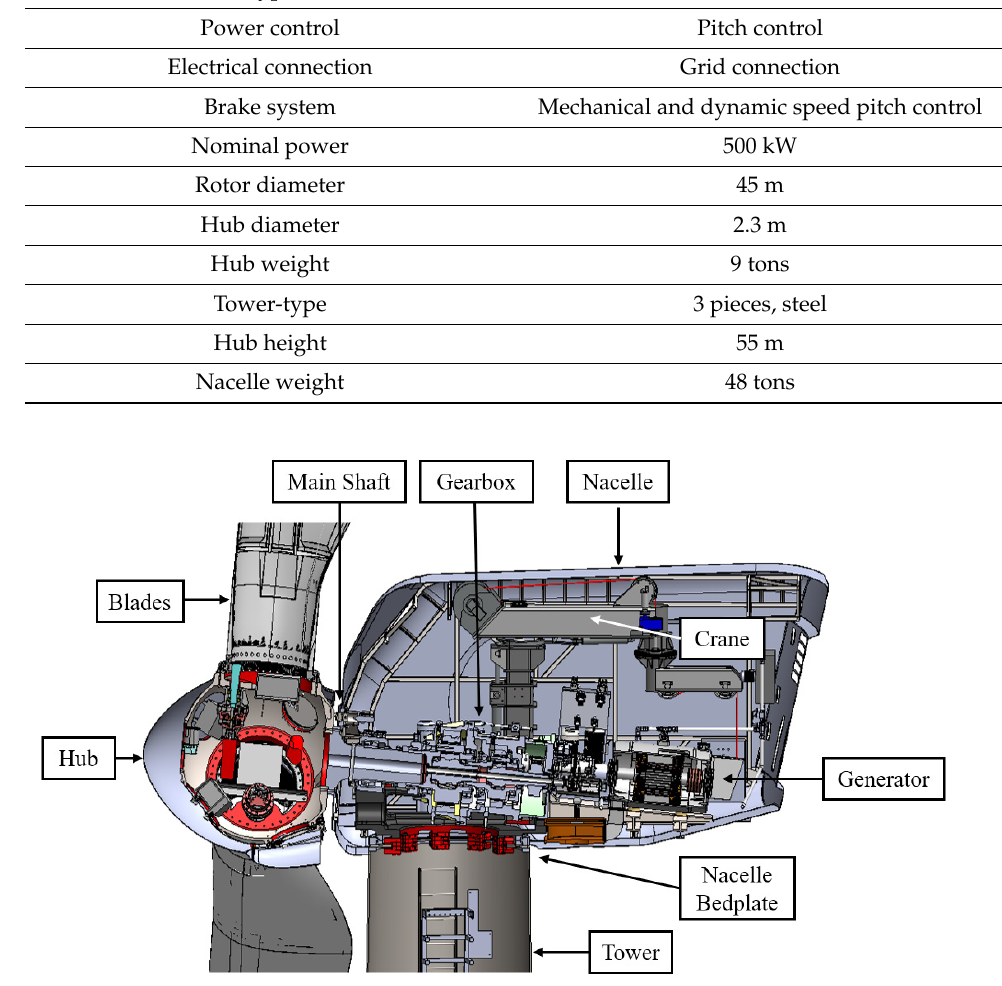
Figure 17. Cross-section of the wind turbine